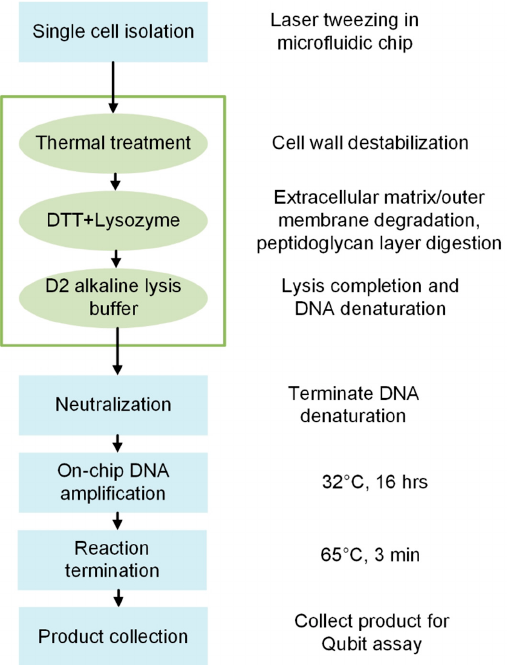
Figure 3. An overview of the workflow of single-cell isolation, lysis, and DNA amplification in a microfluidic chip. The blue rectangles represent standard steps in an on-chip SC-WGA process. The green box highlights the general steps of the lysis protocol developed and optimized.